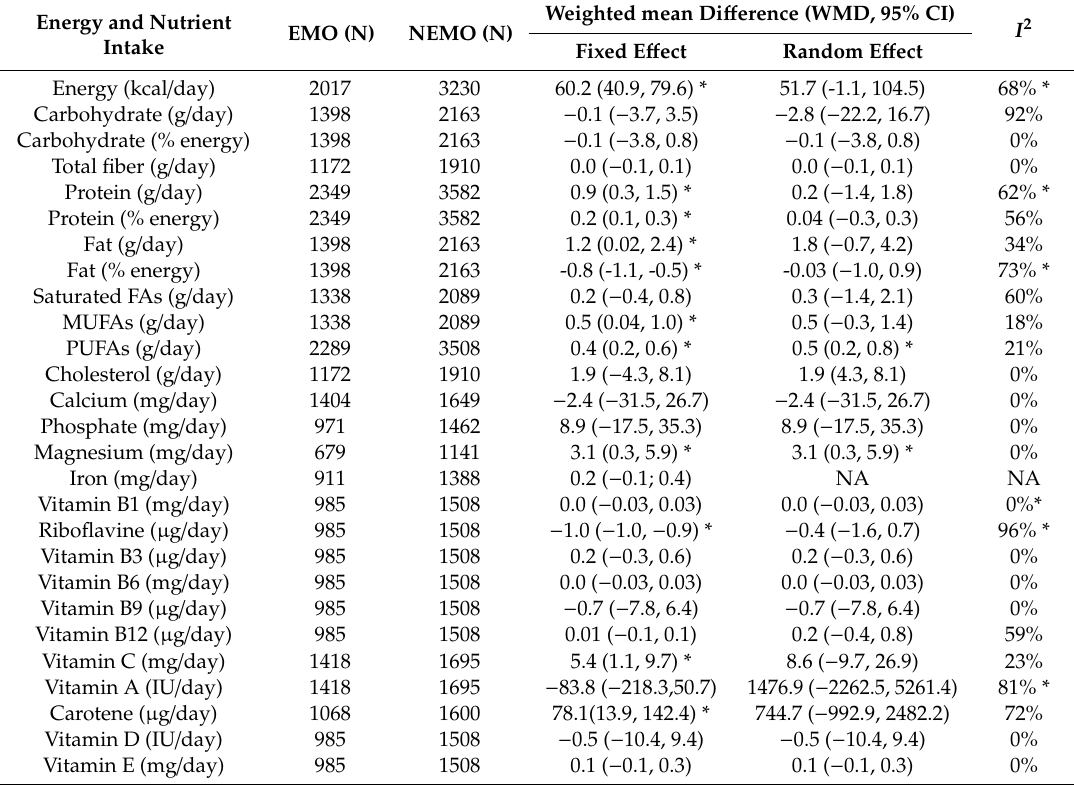
Table 2. Mean di ff erences in nutrient intake between girls with EMO and NEMO.